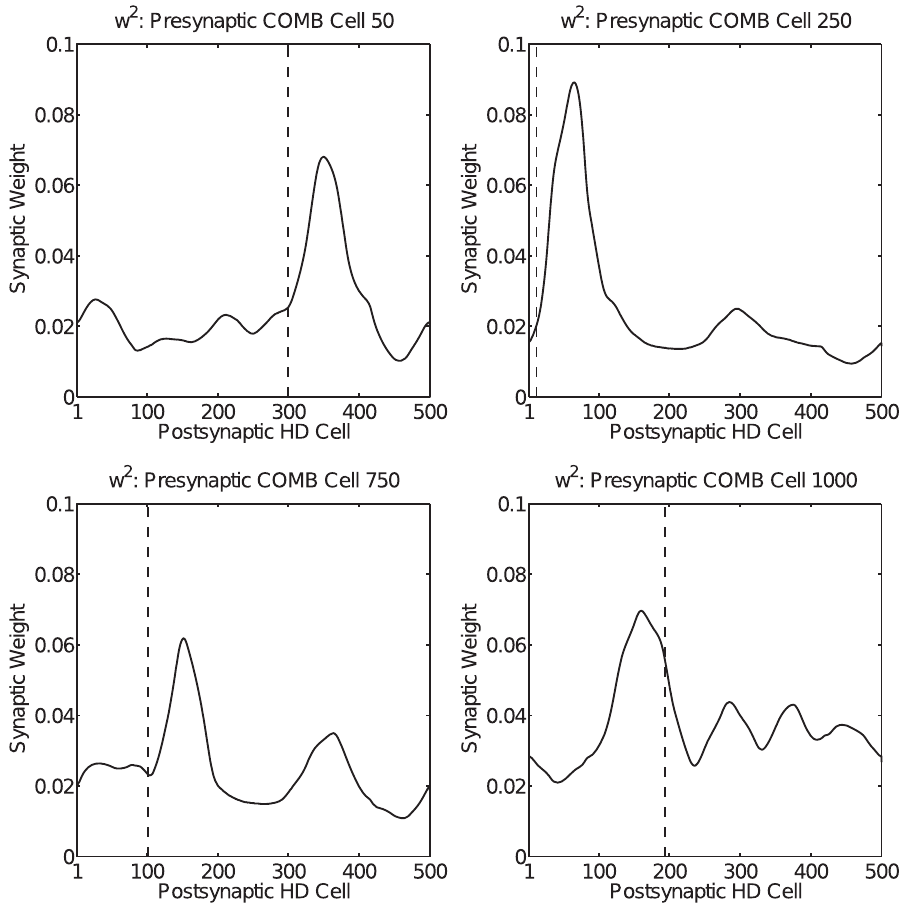
Figure 5. The synaptic weights w 2 from the Combination (COMB) cell network to the Head Direction (HD) cell network after learning with the time-delayed Hebbian associative learning rule (10) and weight normalization (13). These results are from a simulation with an axonal conduction delay of 100 ms, and a rotational velocity during training of 180 0 = sec (all other parameters are as given in Table 1). Each of the four plots shows the learned synaptic weights from a different presynaptic COMB cell to the 500 postsynaptic HD cells. The postsynaptic HD cells are arranged in the plots according to where they fire maximally in the head-direction space of the agent when visual input is available. For each plot, a dashed vertical line indicates the postsynaptic HD cell with which the presynaptic COMB cell has maximal w 3 synaptic weight as shown in Figure 4. In each plot, the w 2 synaptic weight profile is asymmetric about the postsynaptic HD cell with maximal w 3 synaptic weight, indicating that the presynaptic COMB cell preferentially stimulates an HD cell representing a different head direction to the HD cell from which the COMB cell receives maximal w 3 synaptic weight. This reflects the fact that the packet of HD cell activity will have moved through the head-direction space of the agent in the time it takes for a signal to travel from the HD cells through the w 3 synapses to the COMB cells, and back again to the HD cells through the w 2 synapses. Thus, the axonal conduction delays in the w 2 and w 3 synapses act, through learning, as a timing mechanism that enables the update of the packet of head-direction cell activity at the same speed as the agent is